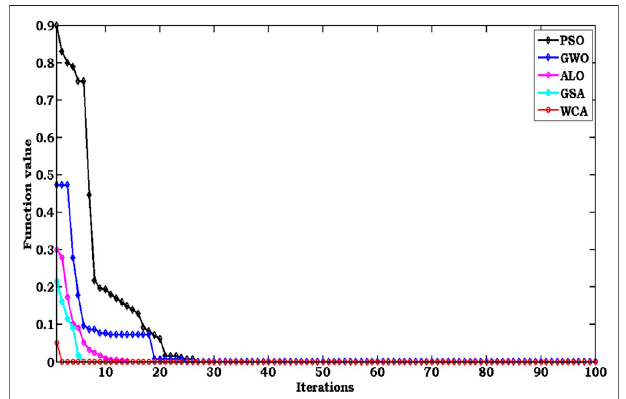
FIGURE 7 | Convergence of different optimizations tested on Booth function.